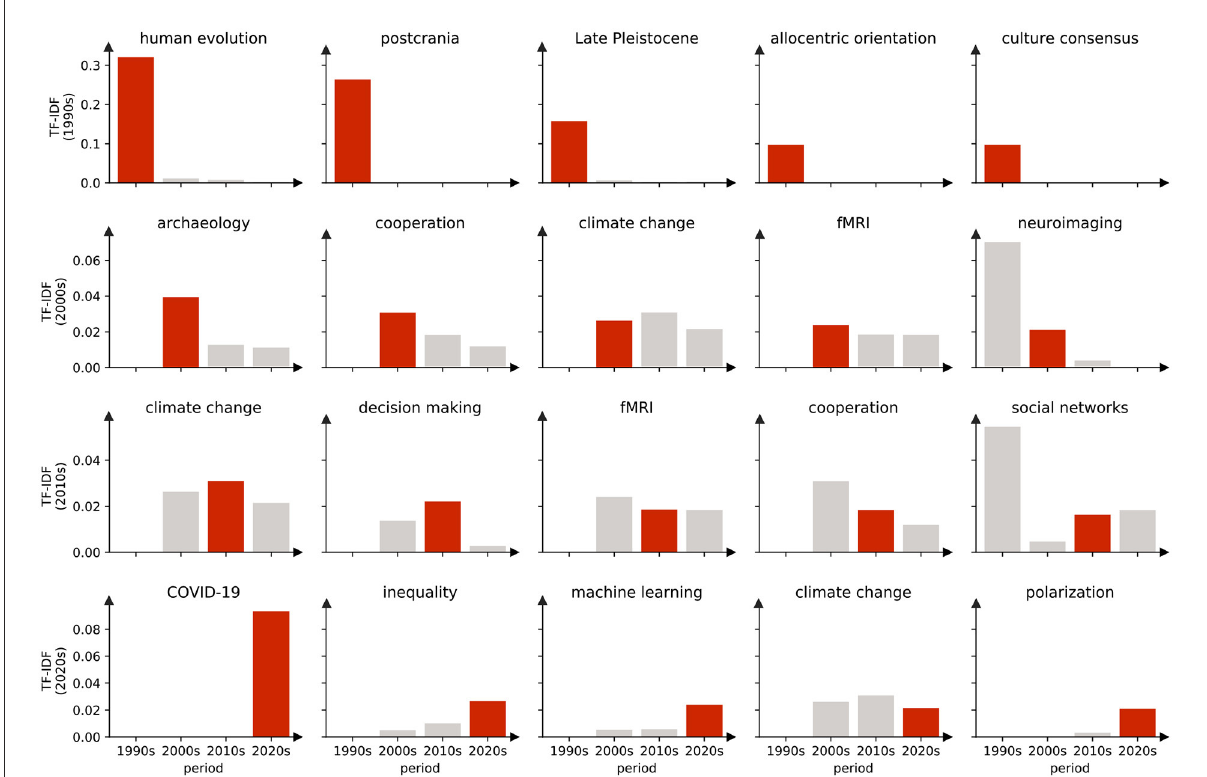
FIGURE14 Top five elite keywords for each era, most of which have the highest TF-IDF values in their corresponding eras. For example, the TF-IDF values of the five keywords in the 1990s obviously have the maximum value in the 1990s, and are almost all 0 in the 2000s and after, corresponding to these values only important for the 1990s. But there were also keywords that were represented as elite keywords in more than one era. For example, climate change, which was classified as an elite keyword in the 2000s, 2010s, and 2020s, is an area of concern.